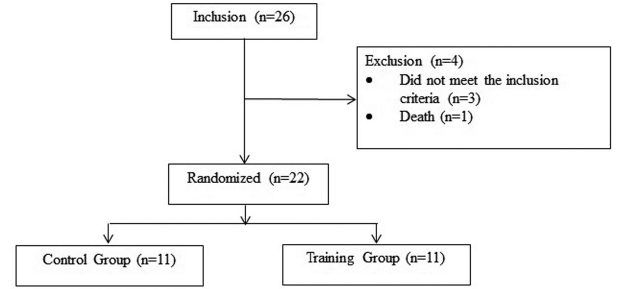
Fig. 1 - Flowchart of studied